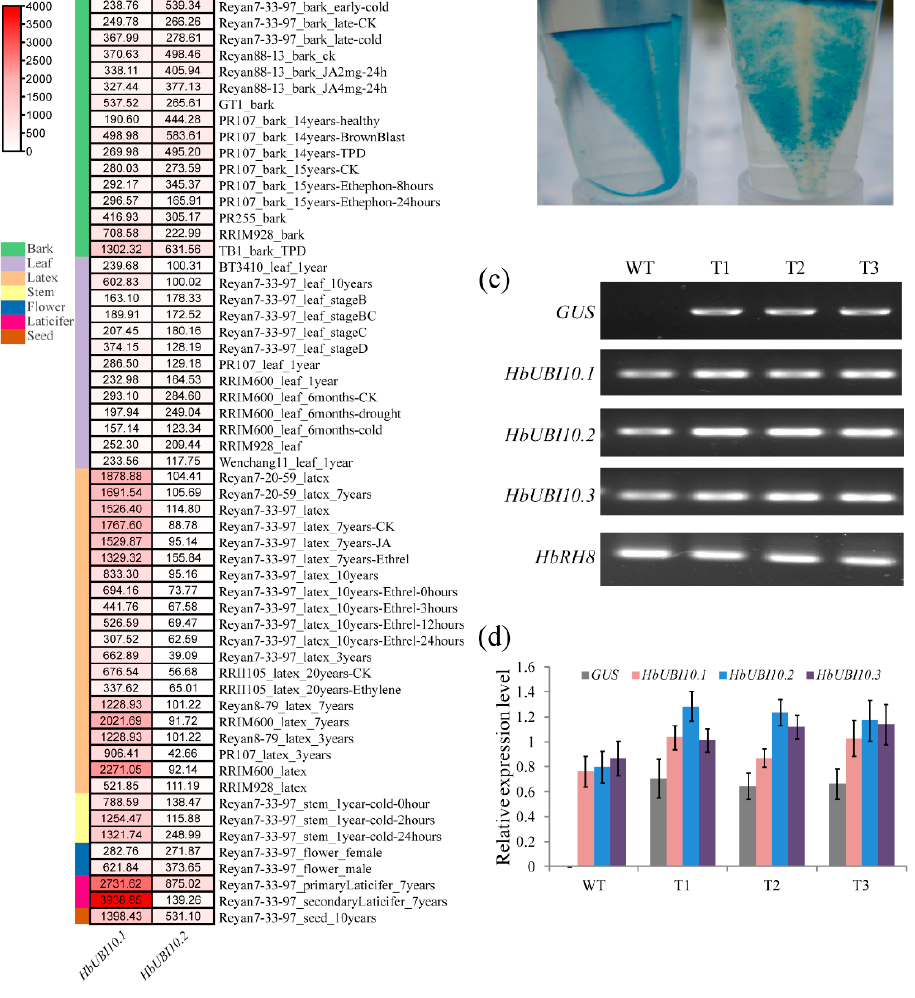
Figure 3. Expressions of three HbUBI genes in Hevea brasiliensis . ( a ) Expression profiles of HbUBI10.1 and HbUBI10.2 genes in various tissues of multiple Hevea clones at different developmental stages. Normalized transcript levels are displayed as FPKM values in the heatmap. Row names denote the Hevea clone, type of tissue, age and treatment. Abbreviations: JA, jasmonic acid; TPD, tapping panel dryness; stageB, bronze stage; stageBC, color-changing stage; stageC, light green stage; stageD, stable stage. ( b ) GUS staining of the leaves from 1-year-old transgenic Hevea plants harboring a GUS gene driven by the CaMV35S promoter. ( c ) Semi-quantitative RT-PCR analysis of the endogenous expression levels of three HbUBI genes in transgenic Hevea plants bearing a GUS gene driven by the CaMV35S promoter. WT represents the wild-type control, while T1, T2 and T3 represent three individual transgenic Hevea plants. ( d ) Relative expressions of three HbUBI genes and GUS in the leaves of 1-year-old transgenic Hevea plants. The mean relative expressions with standard deviation were calculated from three replicates of semi-quantitative RT-PCR reactions.